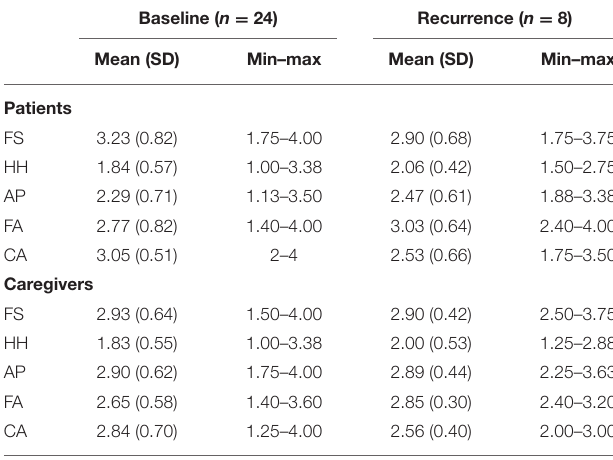
TABLE 2 | Results of assessments at baseline and recurrence in patients and